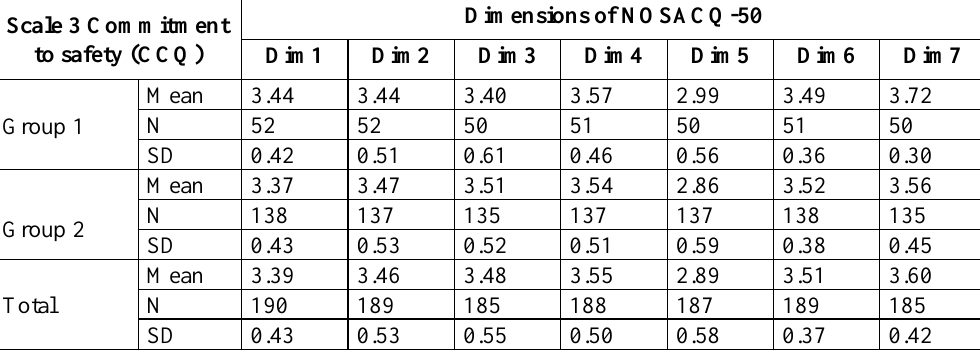
Table 6 . Relationships between Factors of Safety Climate and Scale of Professional Competence “Commitment to Safety” among Caregivers Scale 3 Commitment